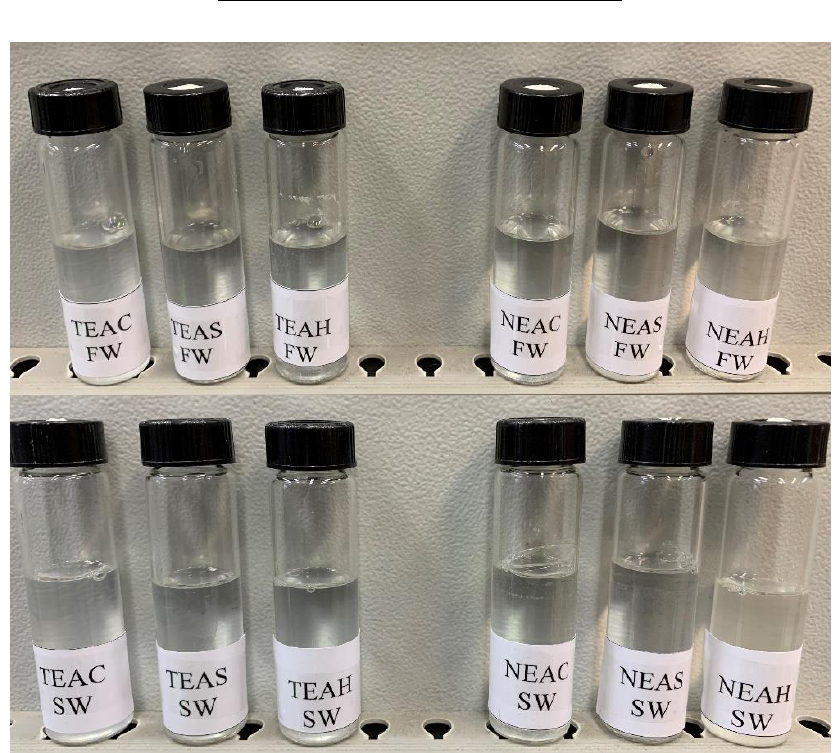
Figure 6. Snapshot of oven aged samples of zwitterionic surfactants at 90 °C for 90 days in seawater (SW) and reservoir brine (FW). Table 5. The composition of seawater and formation water.